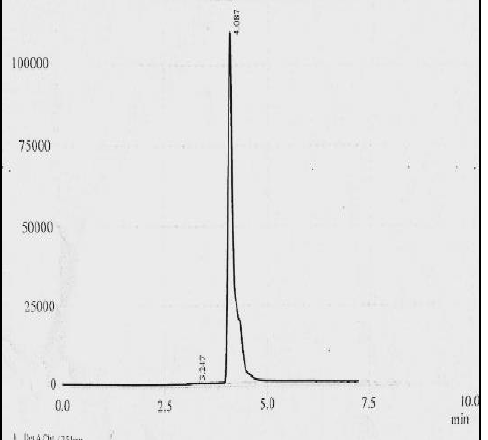
Figure 11. HPLC chromatogram of abrine standard alkaloid. FTIR The IR spectrum of isolated alkaloid showed the characteristic bands which are reported for abrine standard as shown in (table 5) and figure (12).